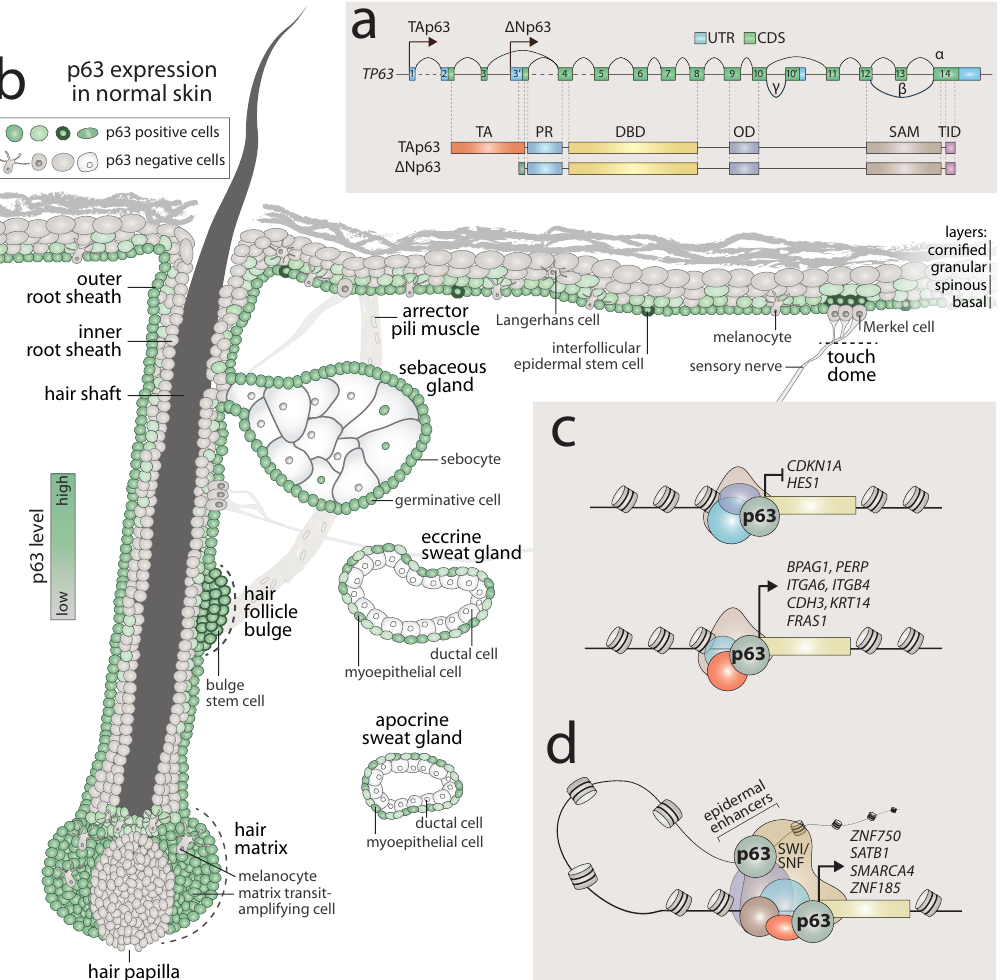
Figure 1. p63 function in normal skin. ( a ) Two di ff erent promoters on the TP63 gene can give rise to TAp63 and ∆ Np63 isoforms. These can be further spliced at the C-terminus, producing α , β , or γ isoforms. ∆ Np63 α is the most abundant isoform in normal skin as well as in skin tumours. p63 protein harbours TA (transcription activation), PR (proline-rich), DBD (DNA-binding), OD (oligomerisation), SAM (sterile α -motif), and TID (transcriptional inhibitory) domains. ( b ) p63 is expressed in most cells of the basal and suprabasal layers of the epidermis but its expression is decreased in the upper spinous layer and absent in the granular and cornified layers of epidermis. p63 intensively marks basal cells of the sebaceous and sweat glands, yet it is not present in mature sebocytes as well as the ductal cells of sweat glands. The cells of the hair matrix, hair bulge stem cells, and outer root sheath show high expression of p63. By contrast, well di ff erentiated cells of the inner root sheath and hair shaft lack p63. Melanocytes and cells of mesenchymal origin, fibroblasts and endothelial cells (not shown), are p63 negative. No data are available regarding p63 expression in Langerhans and Merkel cells (shown as negative); ( c ) In basal layer keratinocytes, p63 plays a crucial role in the maintenance of cell proliferation as well as adhesion. Through direct binding to the promoters of target genes, p63 can repress (upper panel) or activate (lower panel) gene expression; ( d ) During the early stages of keratinocyte di ff erentiation, p63 activates expression of the master regulator of epithelial di ff erentiation, ZNF750, and chromatin remodelers, Brg1 and Satb1. Furthermore, p63 co-operates with chromatin remodeler complex SWI / SNF and binds to epithelial-specific enhancers to allow for the transcriptional activation of a terminal di ff erentiation programme (e.g.,